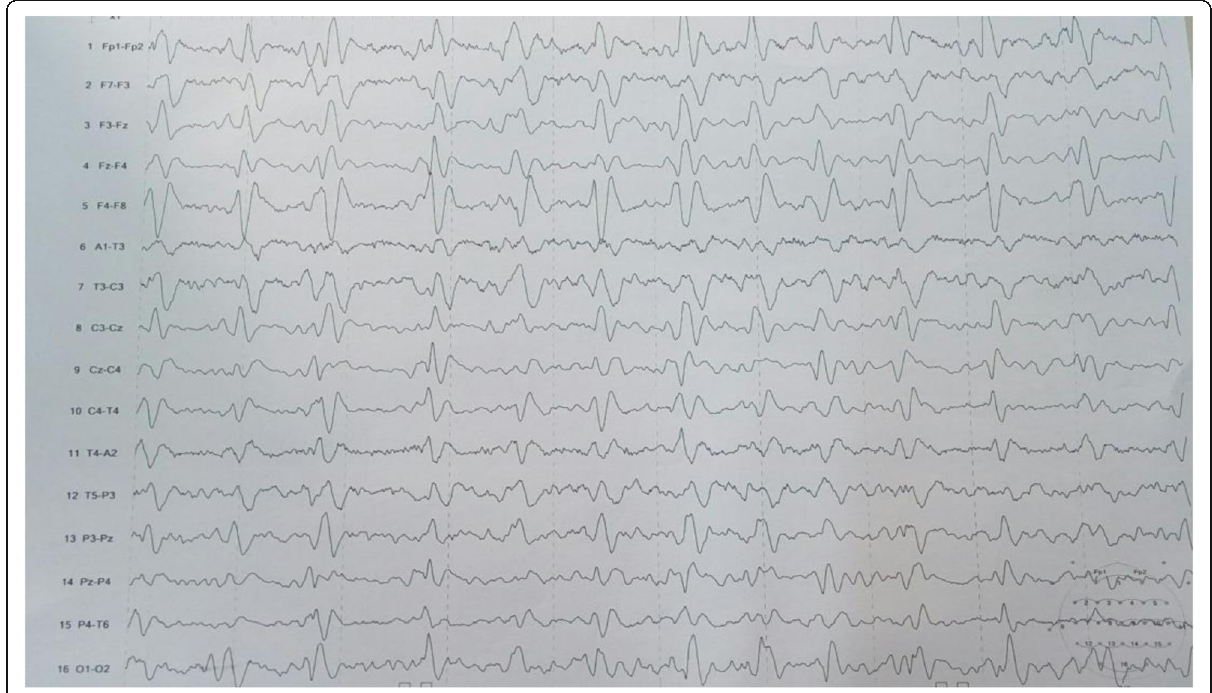
Fig. 1 EEG shows the high-amplitude periodic generalized sharp wave with diffuse slow